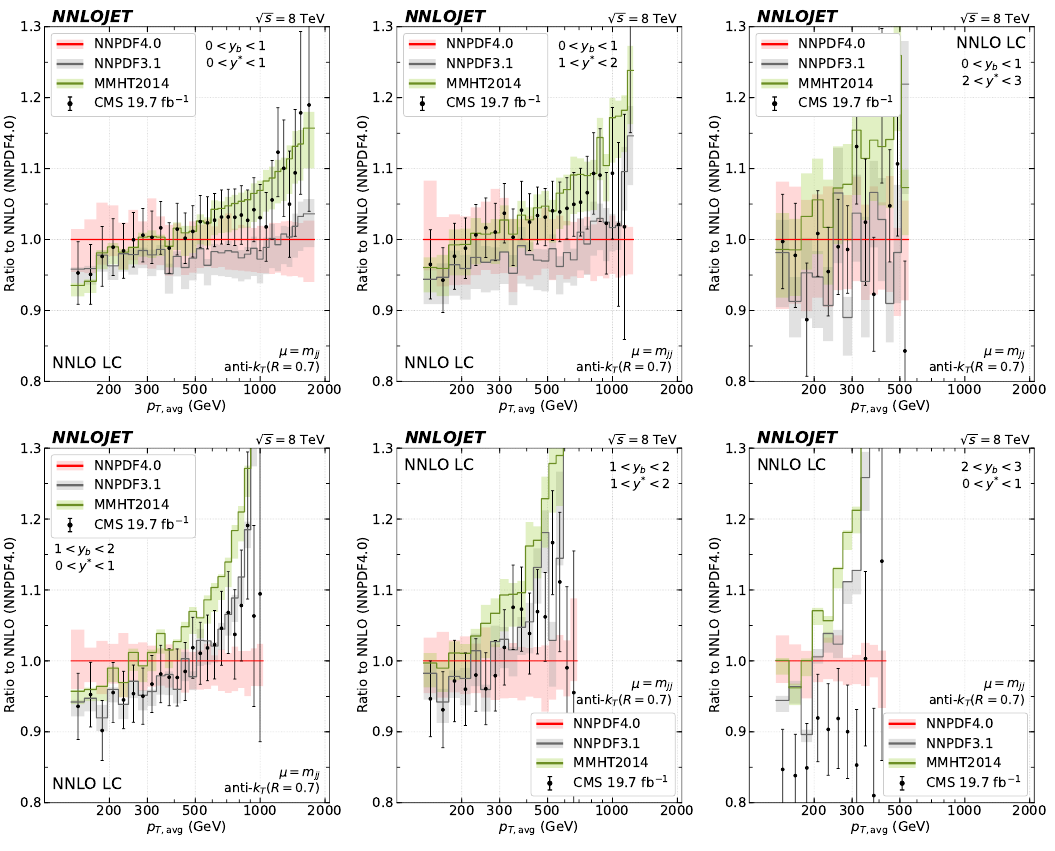
Figure 11 . Comparison of the triple differential dijet distributions at leading colour NNLO ⊗ NP ⊗ EW using NNPDF40_nnlo_as_01180 (red), NNPDF31_nnlo_as_0118 (grey) and MMHT2014_nnlo (green) as the